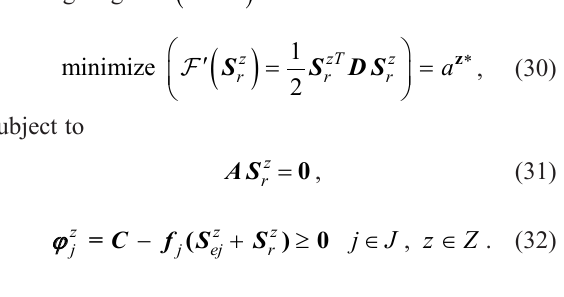
F F ; b) 1st scanning stage; c) sup inf